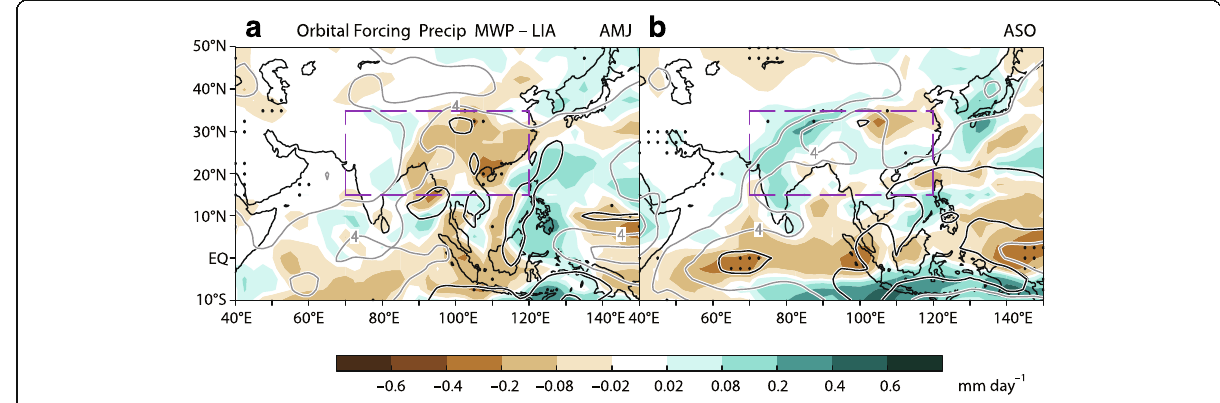
Fig. 6 Similar to a Fig. 2a and b Fig. 2b, but for MRI-CGCM2.3 orbital forcing